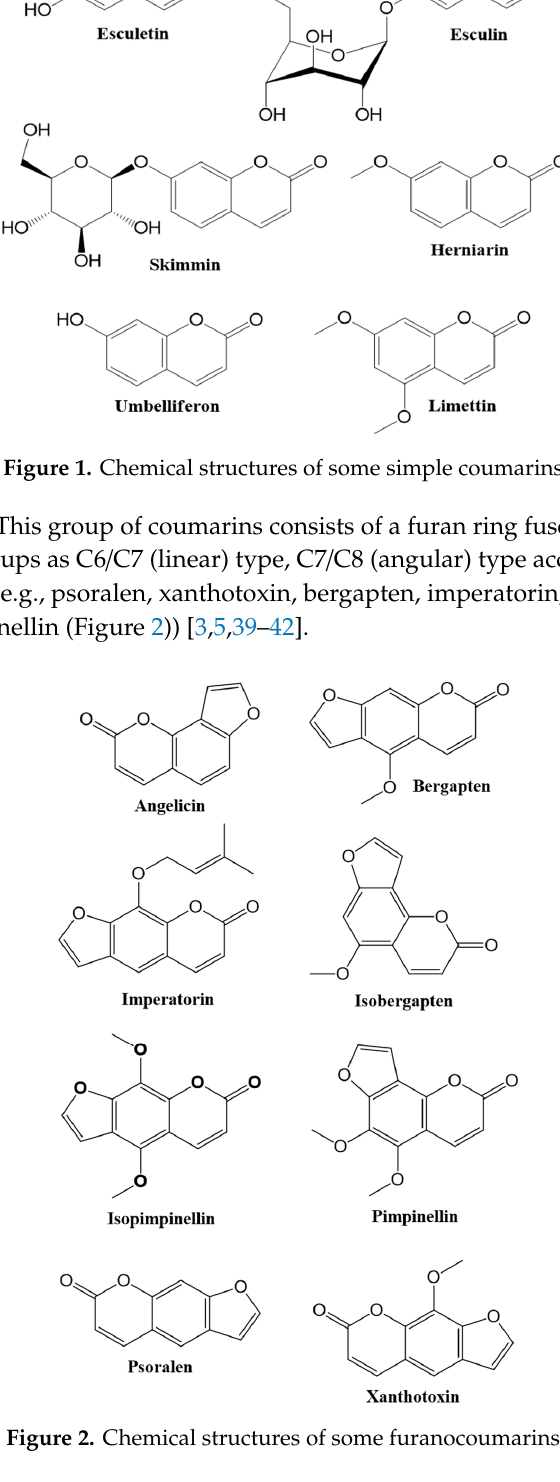
Figure 3. Chemical structures of some pyranocoumarins. Pyrone-substituted coumarins: These are classified in three groups: 4-Hydroxycoumarin (Novobiocin and Dicumarol), 3-Phenylcoumarin (Coumestroln and Gravelliferone) and 3,4- Benzocoumarin (Aeternaryiol). 4-Hydroxycoumarins are not found in plants in free form. Warfarin, a synthetic compound, belongs to this group (Figure 4) [39,44].